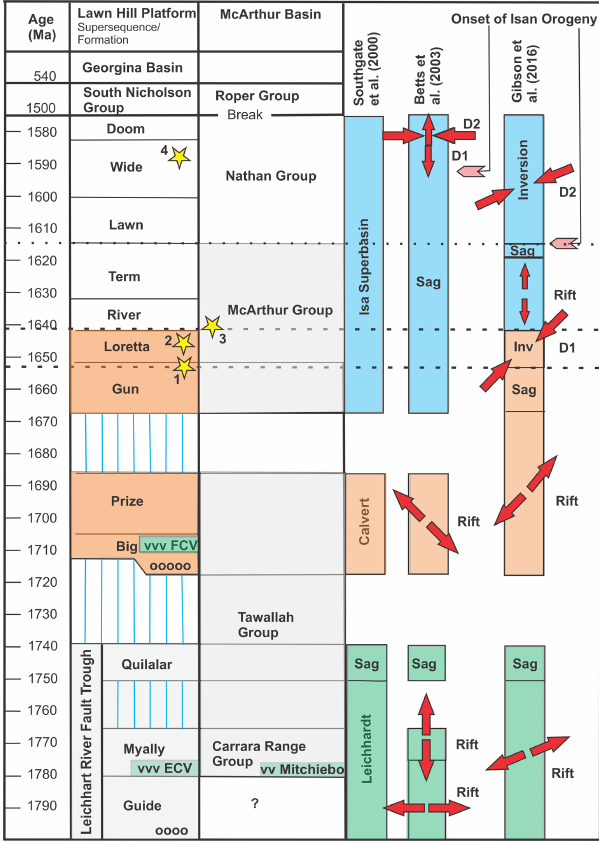
Figure 3. Simplified stratigraphic column for Mount Isa region and neighbouring southern McArthur Basin showing three-fold subdi- vision into the Leichhardt, Calvert, and Isa superbasins but dif- ferent interpretations of basin history and tectonic evolution (Betts and Lister, 2001; Betts et al., 2003; Gibson et al., 2016; Southgate et al., 2000a). The Carrara Range Group is shown as part of the lower Tawallah Group and a correlative of the Leichhardt Super- basin based on revised geological mapping (Rawlings et al., 2008) and recently published geochronological data (Kositcin and Carson, 2019) for the McArthur Basin. Vertical blue lines represent periods of non-deposition or missing geological record; open circles: basal conglomerates; vvv: basaltic volcanic rocks. Individual Pb–Zn de- posits are shown as yellow stars: 1: Mount Isa; 2: Lady Loretta; 3: McArthur River; 4: